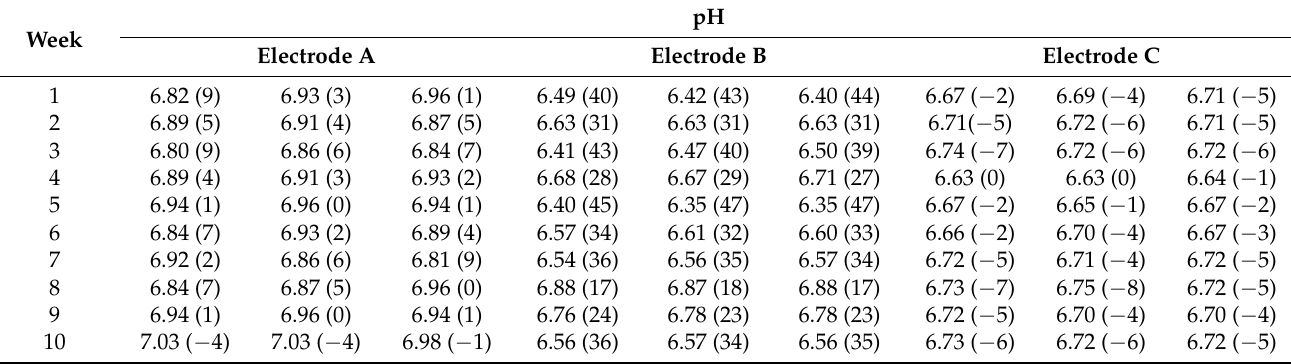
Table 2. Results obtained by electrodes A, B and C, n = 3.